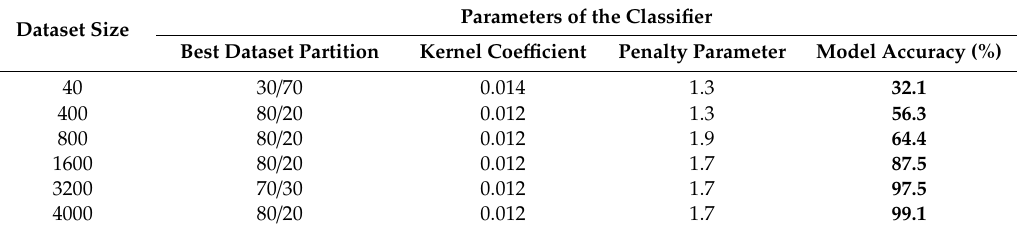
Table 5. Support vector classifier (SVC): best